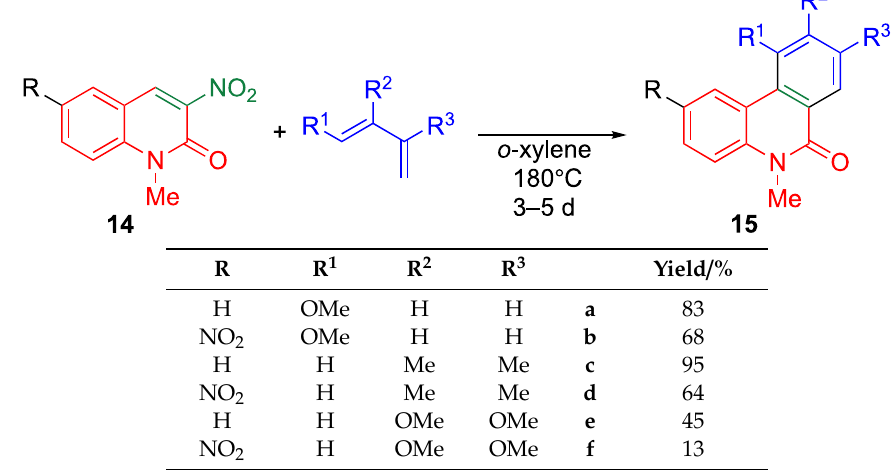
Table 5. Cycloaddition of 3-nitrated quinolones 14 with dienes 2 .